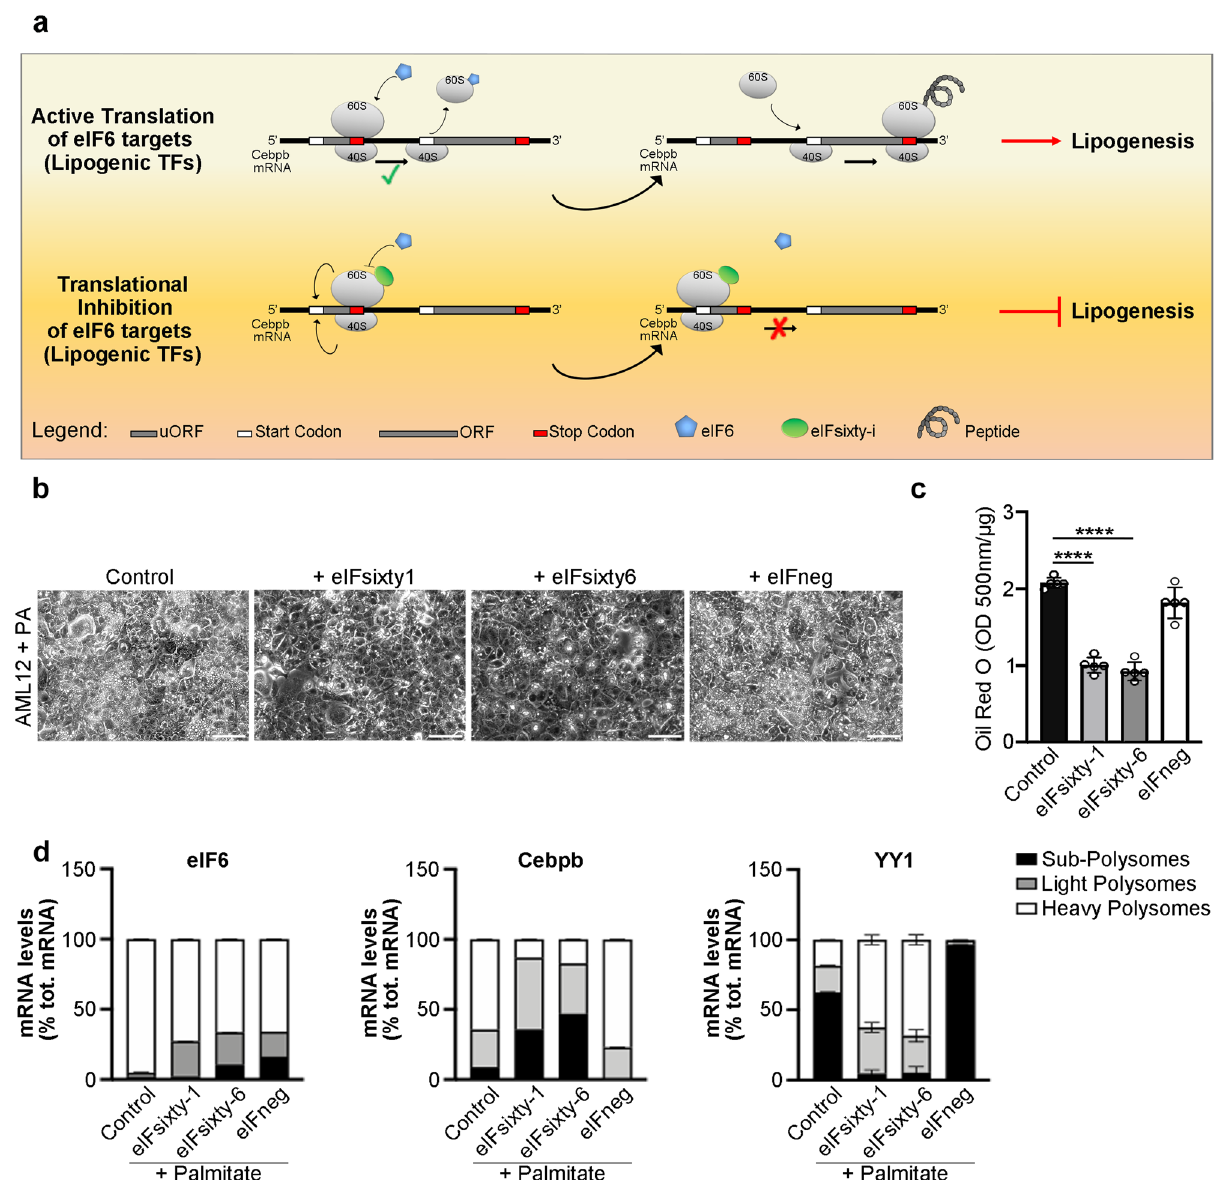
Fig. 8 Pharmacological targeting of eIF6 activity reduces steatosis in murine hepatocytes. a Model of the translational regulation of lipogenic TFs driven by eIF6. eIF6 regulates the translation of C/EBP β mRNA, which contains uORF in its 5 ’ UTR, through re-initiation. eIF6 has an anti-association property: it binds the 60 S ribosomal subunit at the stop codon of the uORF, leading to 60 S release from the 40 S. 40 S can then resume scanning to the main ORF, which encodes for the transcription factor (TOP). eIFsixty compounds prevent eIF6 binding to the 60 S at the stop codon of the uORF. In this case, the inactive 80 S complex is stalled and the translation of the downstream ORF is inhibited (BOTTOM). b Bright- fi eld images of AML12 treated with 2 mM palmitate and with eIFsixty-i compounds. Cells treated with palmitate have increased accumulation of lipid droplets, which is reduced upon eIFsixty-1 and eIFsixty-6 inhibitors treatment. eIFneg is a negative control, an inactive compound of a similar structure. Scale bar = 50 µ m. c Quanti fi cation of Oil Red O content in palmitate-treated AML12 cells. N = 5/condition. Data are represented as means ± SD. Two-tailed t test. d Quanti fi cation of mRNA levels in heavy, light, and subpolysomes of AML12 cells after administration of palmitate and eIFsixty-i compounds. eIFneg was used as a negative control. Only eIFsixty-1 and eIFsixty-6 induce a shift from the polysomal to the subpolysomal peak of eIF6 target C/EBP β mRNA. The same treatment shows the opposite effect on YY1 mRNA. Real-time PCR analysis was performed on n = 3 independent experiments. Stacked bar charts represent the quanti fi cation of selected mRNA levels in heavy, light, and subpolysomes. Data are provided as a Source Data start of the HFD regimen were fasted for 16h and then refed. In all, 1 h after All mice were maintained under speci fi c and opportunistic pathogen-free refeeding, mice were injected intraperitoneally with 50mg/kg body weight pur- conditions and all experiments involving animals were performed in accordance with omycin. In all, 3h after IP injection, mice were killed and livers samples were the Ethical Committee of San Raffaele by experimental protocols approved by national isolated and processed for histological analysis and for puromycin detection by regulators (IACUC no. 688). Mandatory rules for 3Rs and euthanasia were followed. western blotting using anti-puromycin antibodies (Sigma-Aldrich, #MABE343). The quantitation of puromycin staining was performed measuring DAB intensity RNA isolation and Illumina sequencing . Approximately 5 mg of liver tissue from through the Image J software. eIF6 + / + and eIF6 + / − mice not injected with pur- standard or HFD mice were homogenized. RNA was puri fi ed using mirVana TM omycin were used as negative controls. isolation kit (ThermoFisher) according to the manufacturer protocols and as